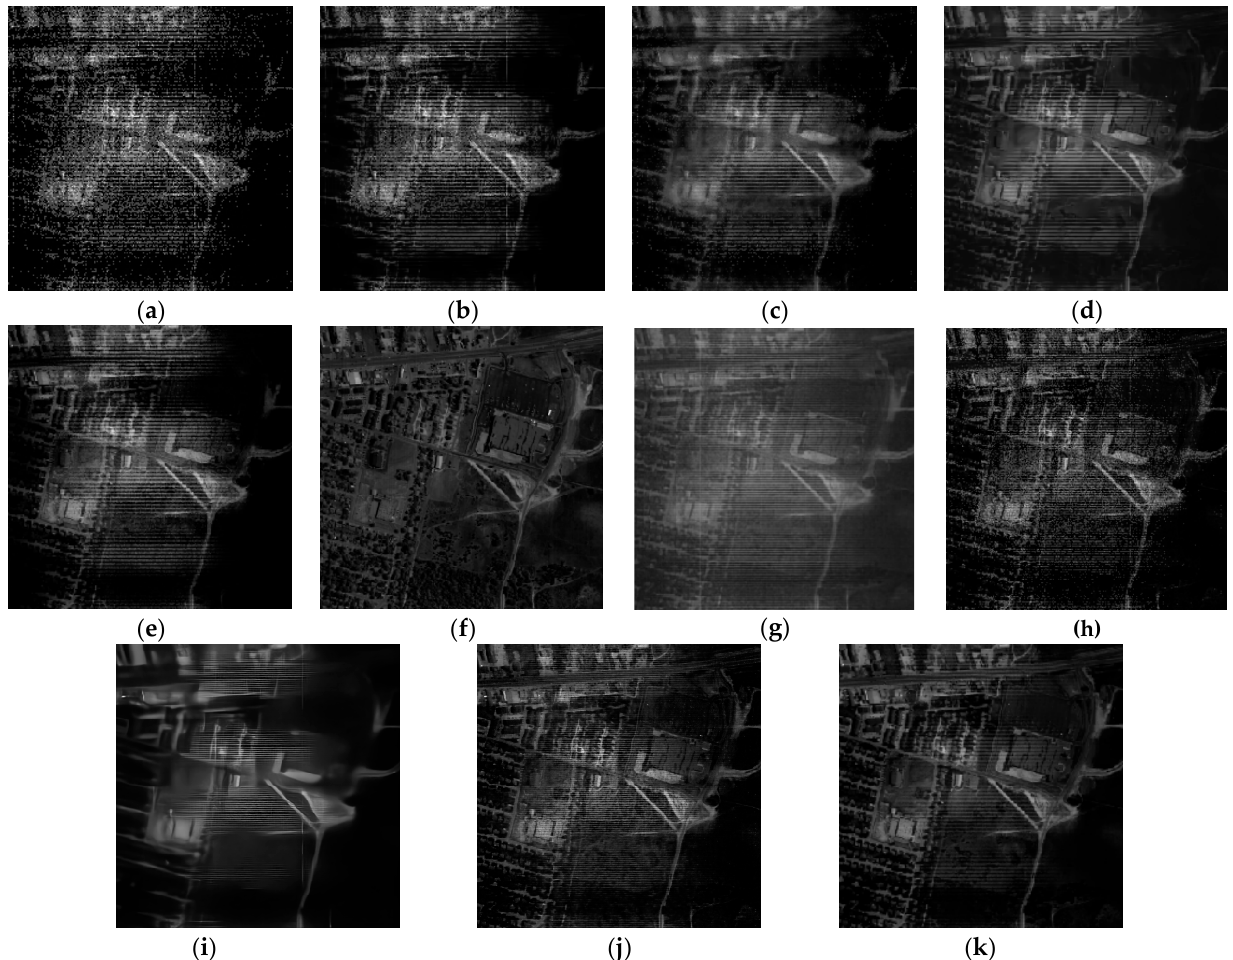
Figure 10. Restored results of the Urban image: ( a ) original band 151; ( b ) BM3D; ( c ) ANLM3D; ( d ) BM4D; ( e ) LRMR; ( f ) GLF; ( g ) LRTDTV; ( h ) LTDL; ( i ) DnCNN; ( j ) HSID-CNN; ( k ) VLRMFmcl.